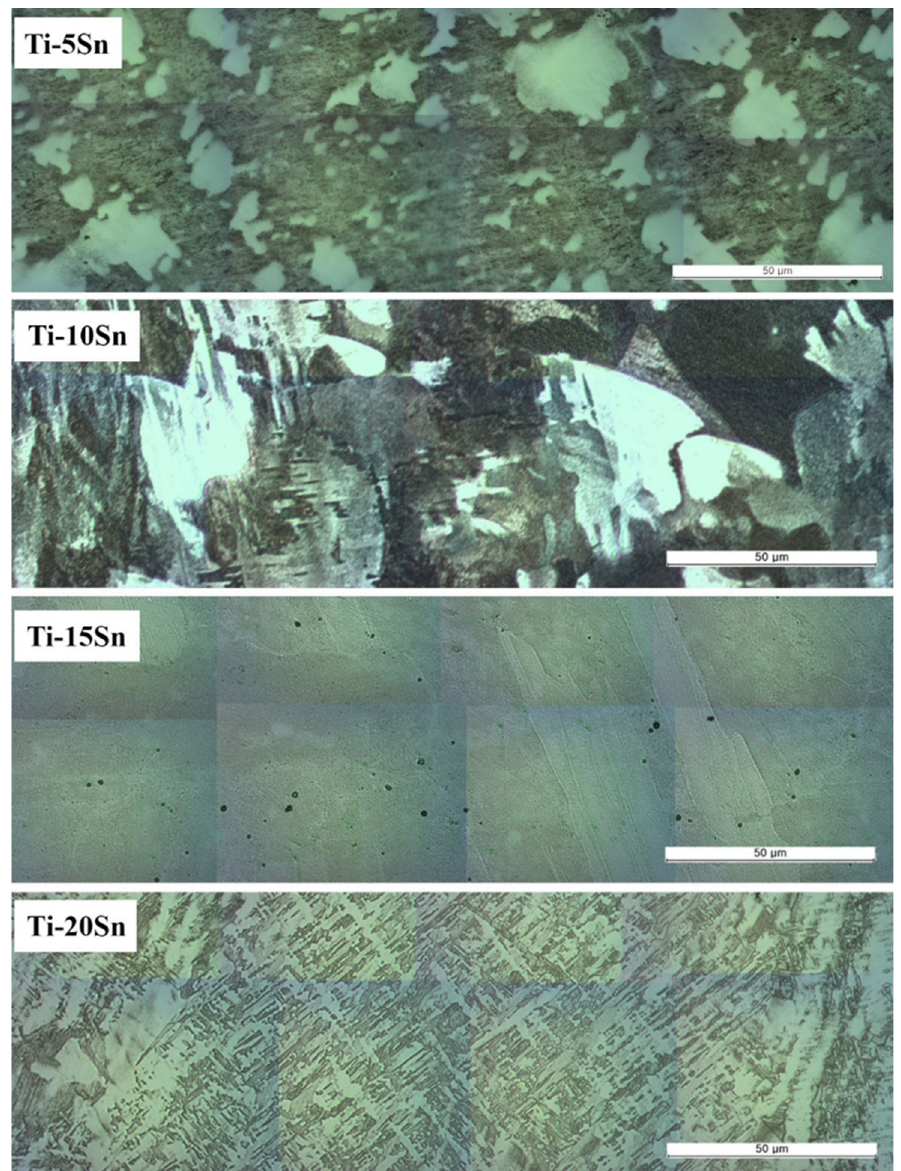
Figure 2. The mosaic-stitching optical microscope images of Ti-xSn alloys (x = 5~20 wt%). Original magnification was ×50.